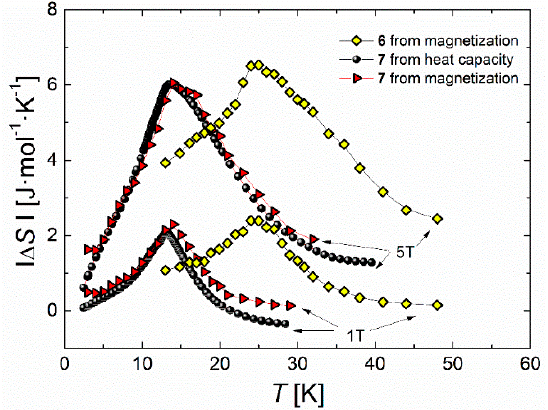
Figure 22. The plot of magnetic entropy change vs temperature corresponding to µ 0 ∆ H = 1, 5 T measured for {[Mn II (pyrazole) 4 ] 2 [Nb IV (CN) 8 ] 3 ·4H 2 O} n and [Fe II (pyrazole) 4 ] 2 [Nb IV (CN) 8 ] 3 ·4H 2 O} n.